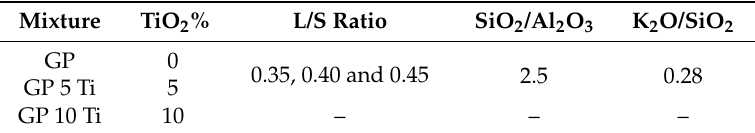
Table 2. Compositions of the